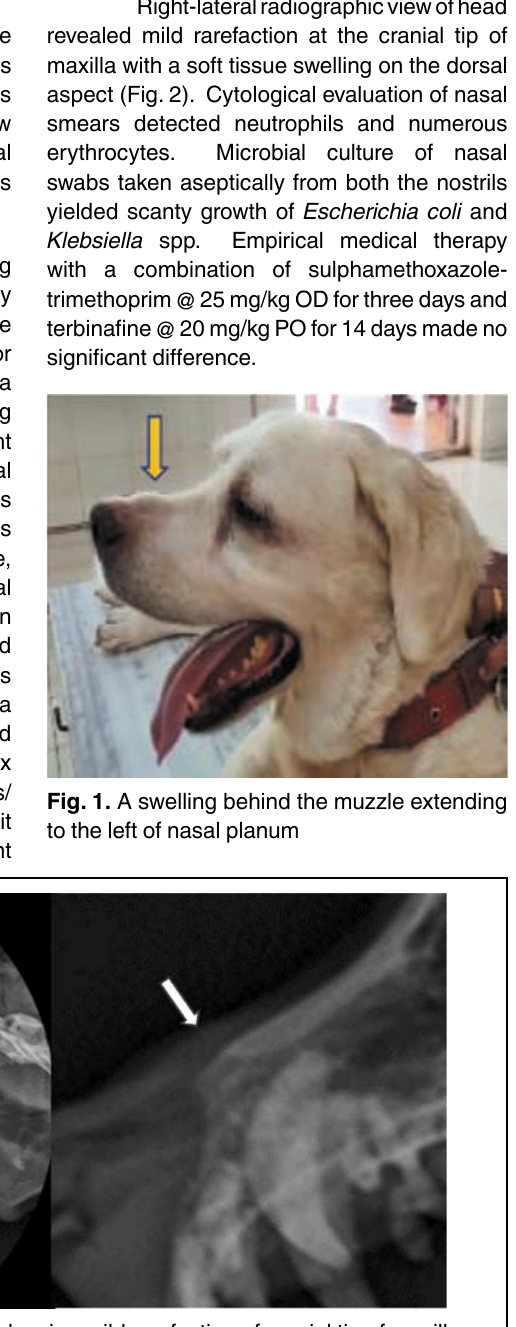
Fig. 2. Radiograph (right lateral) of head showing mild rarefaction of cranial tip of maxilla